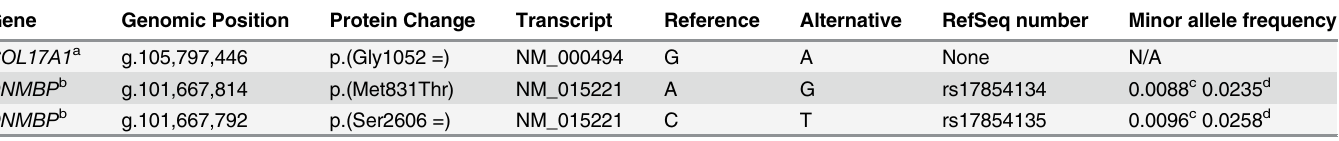
Table 1. Filtered coding region variants in positional candidate genes for the corneal dystrophy linked to chromosome 10q23-q24. Gene Genomic Position Protein Change